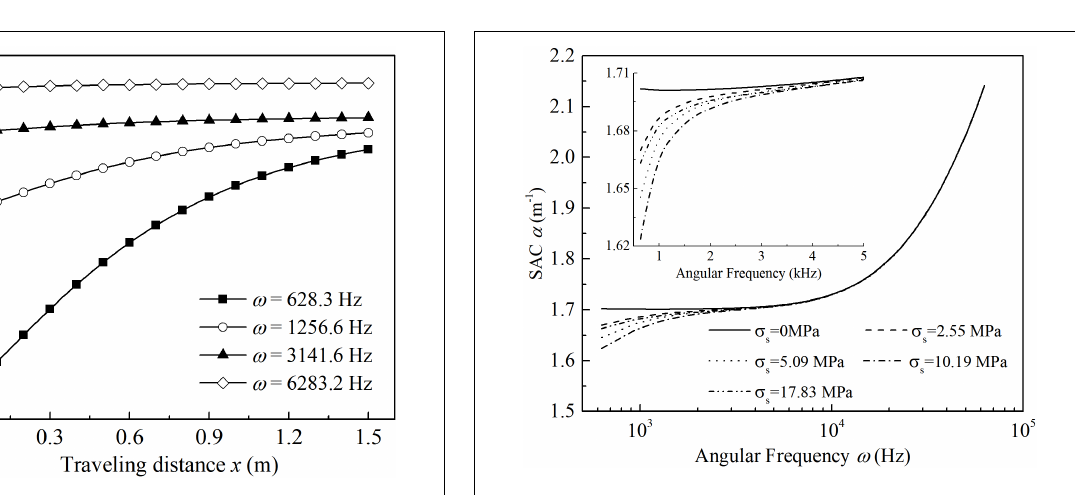
FIGURE 8 | Frequency-dependent spatial attenuation coefficients ( x = 0.2